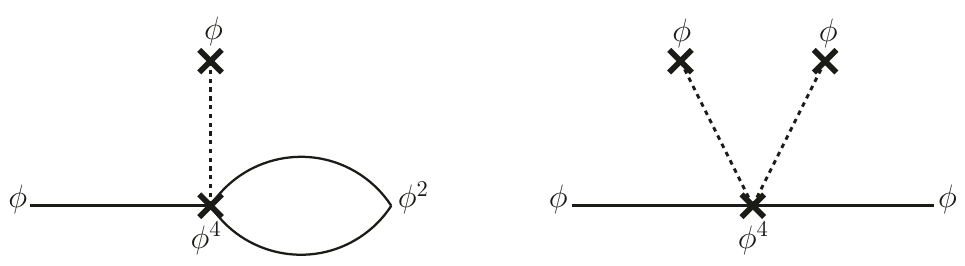
Figure 8 . Leading corrections to the cubic interaction (left) and bare mass (right) in H e(cid:11) due to a tadpole term. Including all diagrams of these two types in the LC Hamiltonian is equivalent to performing the (cid:12)eld rede(cid:12)nition (cid:30) (cid:30) + v !